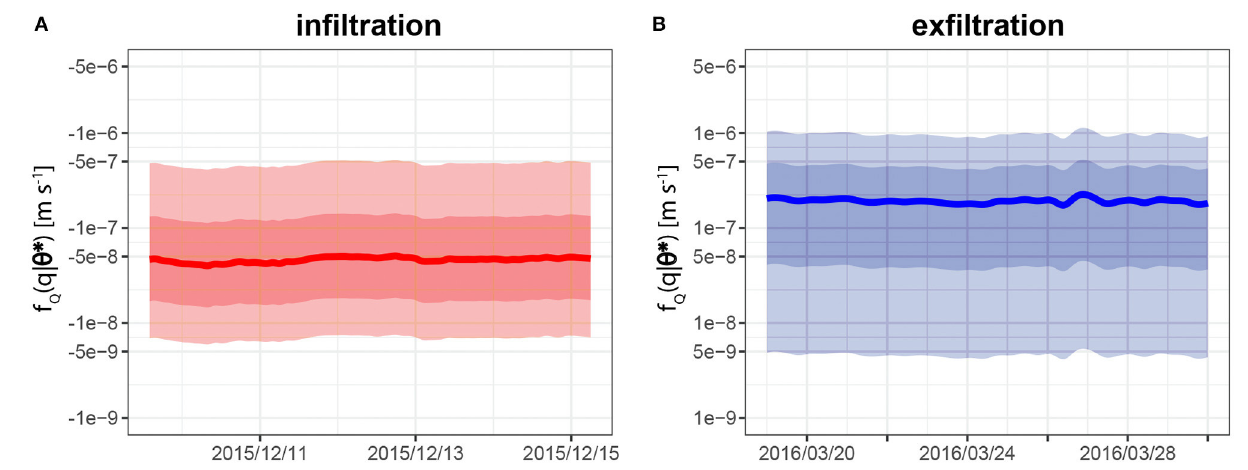
FIGURE 9 | Posterior distributions of specific discharge q . Panels (A,B) refer to the two LOMOS-mini measurement datasets presented in Figure 6 , corresponding to an infiltration and an exfiltration case study respectively. The solid lines represent the medians of the posterior distributions, the shaded intervals correspond to the 50 and 95% posterior intervals. The y-axis is on a logarithmic